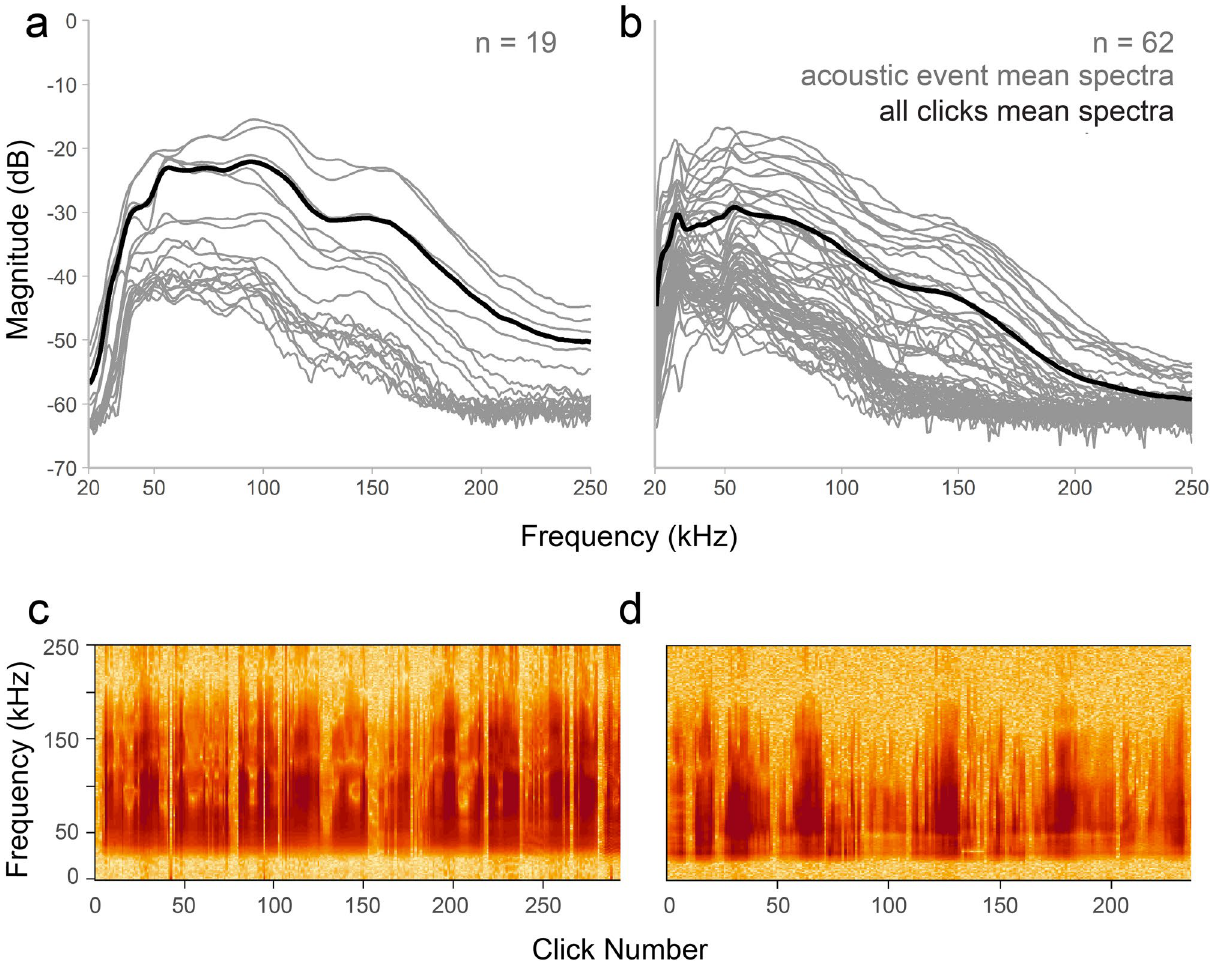
Figure 3. Average spectra and example concatenated spectrograms for beluga ( a , c ) and narwhal ( b , d ) acoustic events. Gray lines in ( a ) and ( b ) show average spectra for individual acoustic events: 19 beluga events and 62 narwhal events. Black lines in ( a ) and ( b ) represent the mean spectra for all echolocation clicks assigned to events for each species: 2537 beluga clicks and 8782 narwhal clicks. Example concatenated spectrograms in ( c ) and ( d ) show one acoustic event for each species (1024 point FFT; Hanning